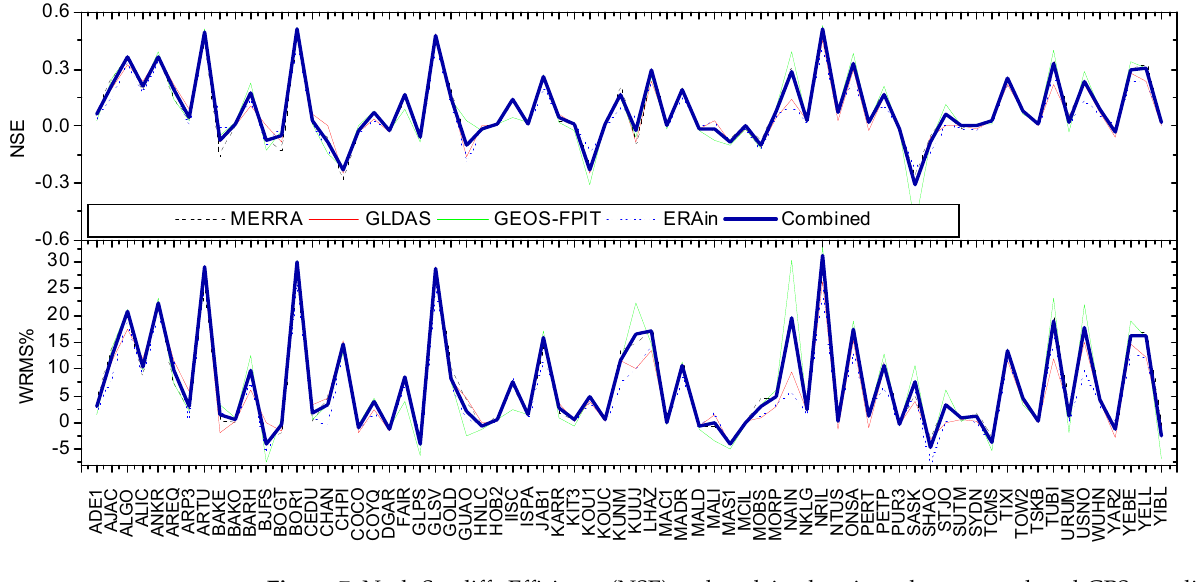
Figure 7. Nash-Sutcliffe Efficiency (NSE) and explained variance between reduced-GPS coordinates and different hydrology loading predictions.